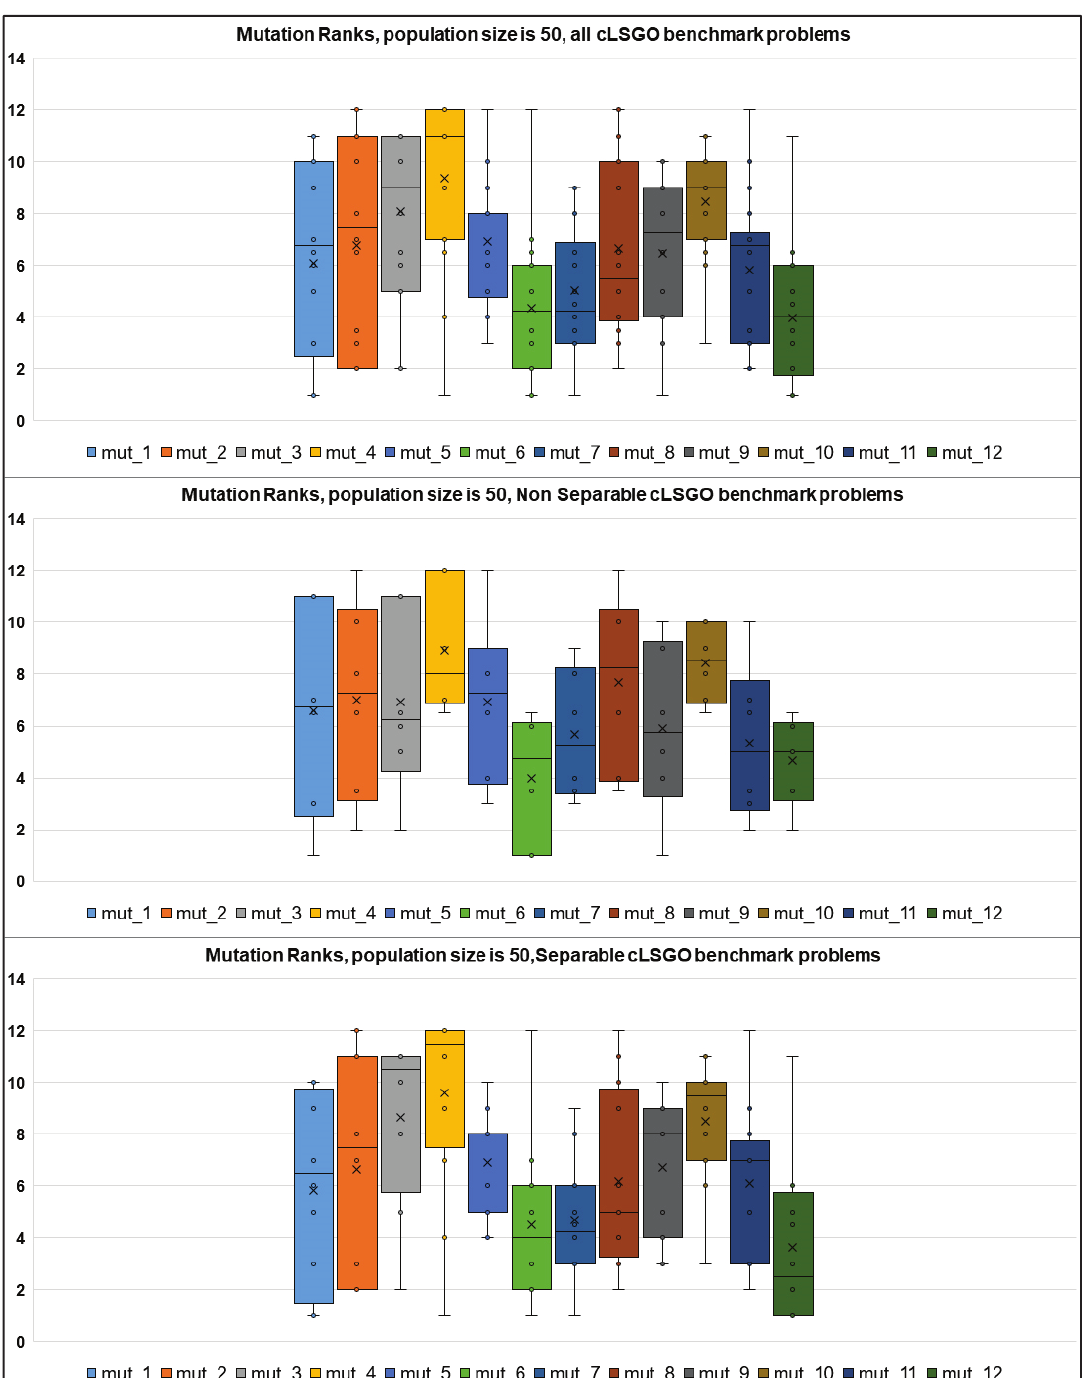
Figure 12. The ranking of different mutation strategies on the cLSGO benchmark problems.